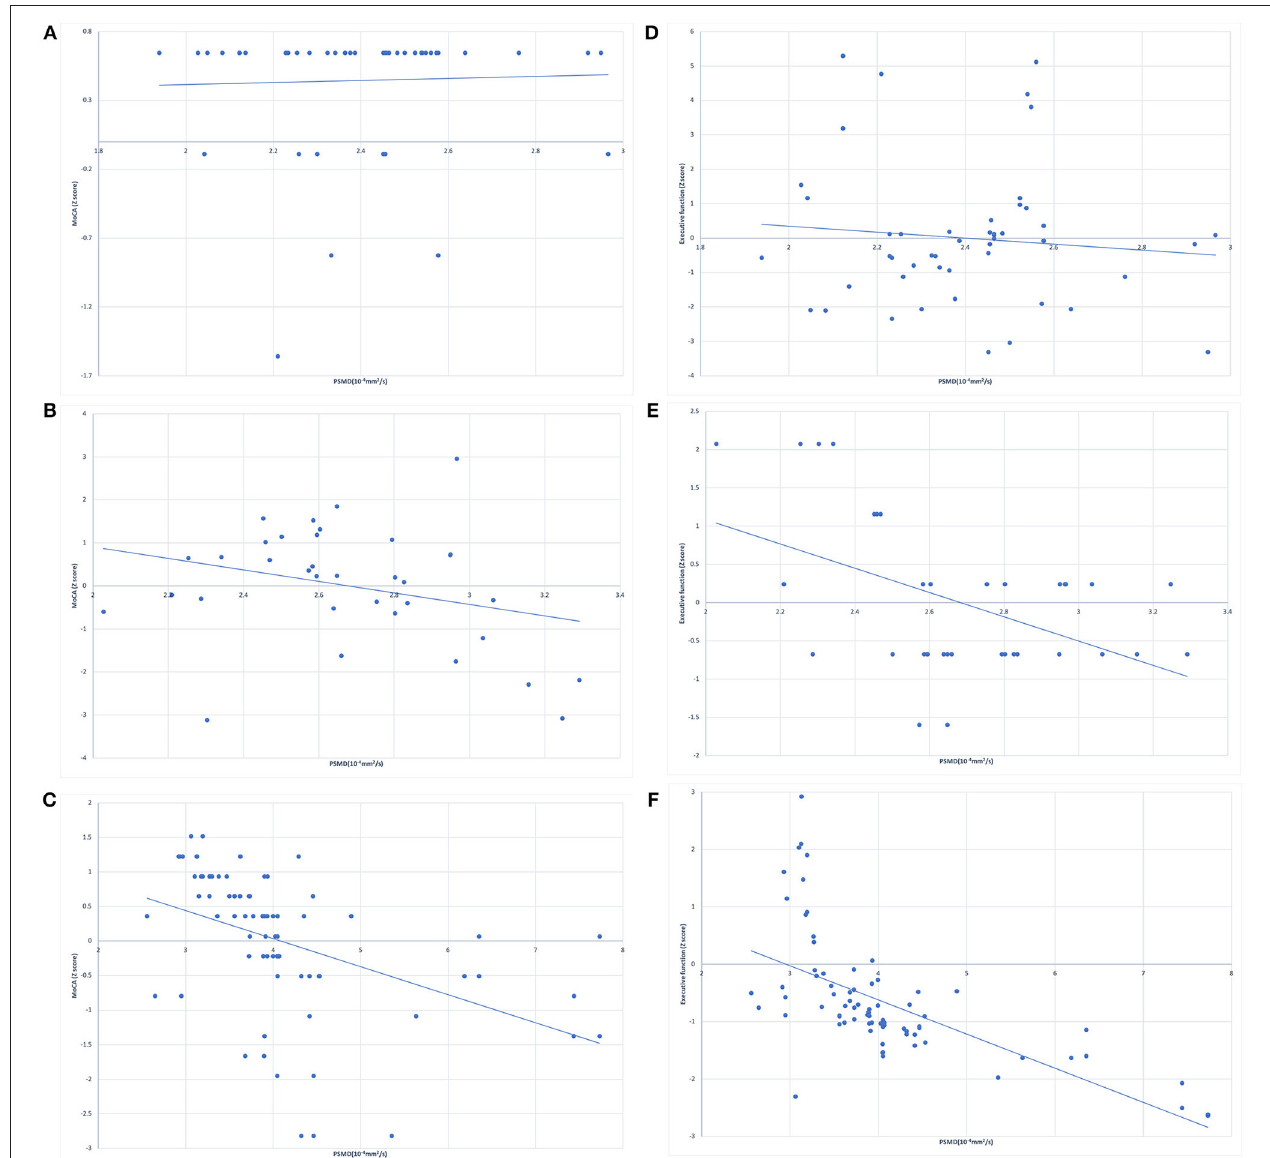
FIGURE 1 | Simple linear regression between peak width of skeletonized mean diffusivity (PSMD) and z scores of MoCA in (A) healthy controls, (B) cognitively normal WML patients, (C) WML patients with vascular cognitive impairment, and for the z scores of executive function in (D) healthy controls, (E) cognitively normal WML patients, (F) the WML patients with vascular cognitive